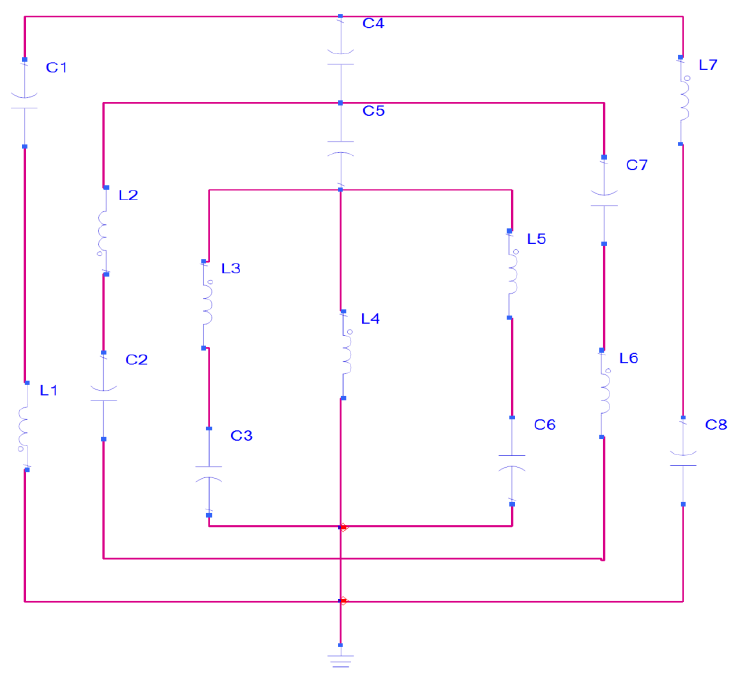
Figure 2. The equivalent circuit of the proposed ISMeTM structure.